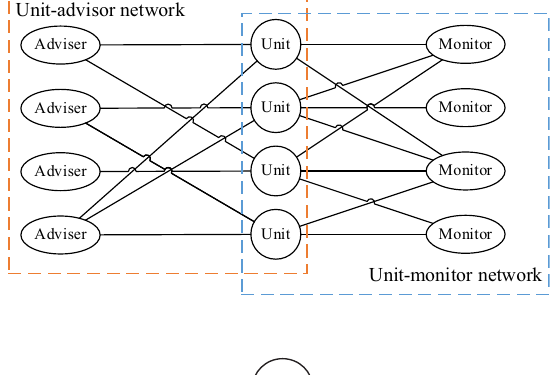
Figure 7. A unit ’ s little world network